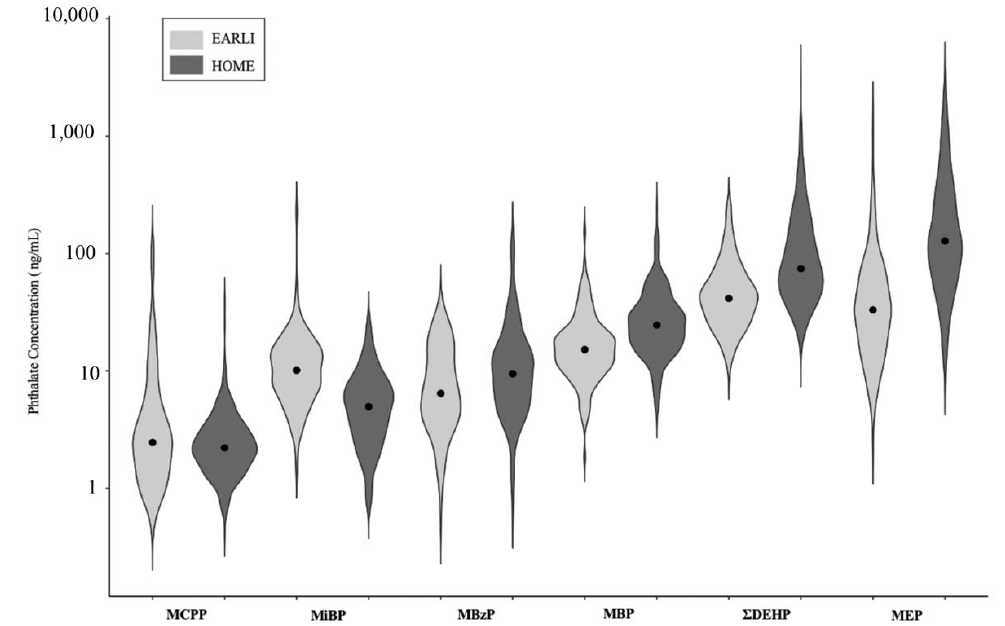
Figure 1. Violin plots of average urinary phthalate metabolite concentrations (ng/mL) during gestation: The Early Autism Risk Longitudinal Investigation (EARLI) (2009–2012) and Health Outcomes and Measures of the Environment (HOME) Studies (2003–2006).